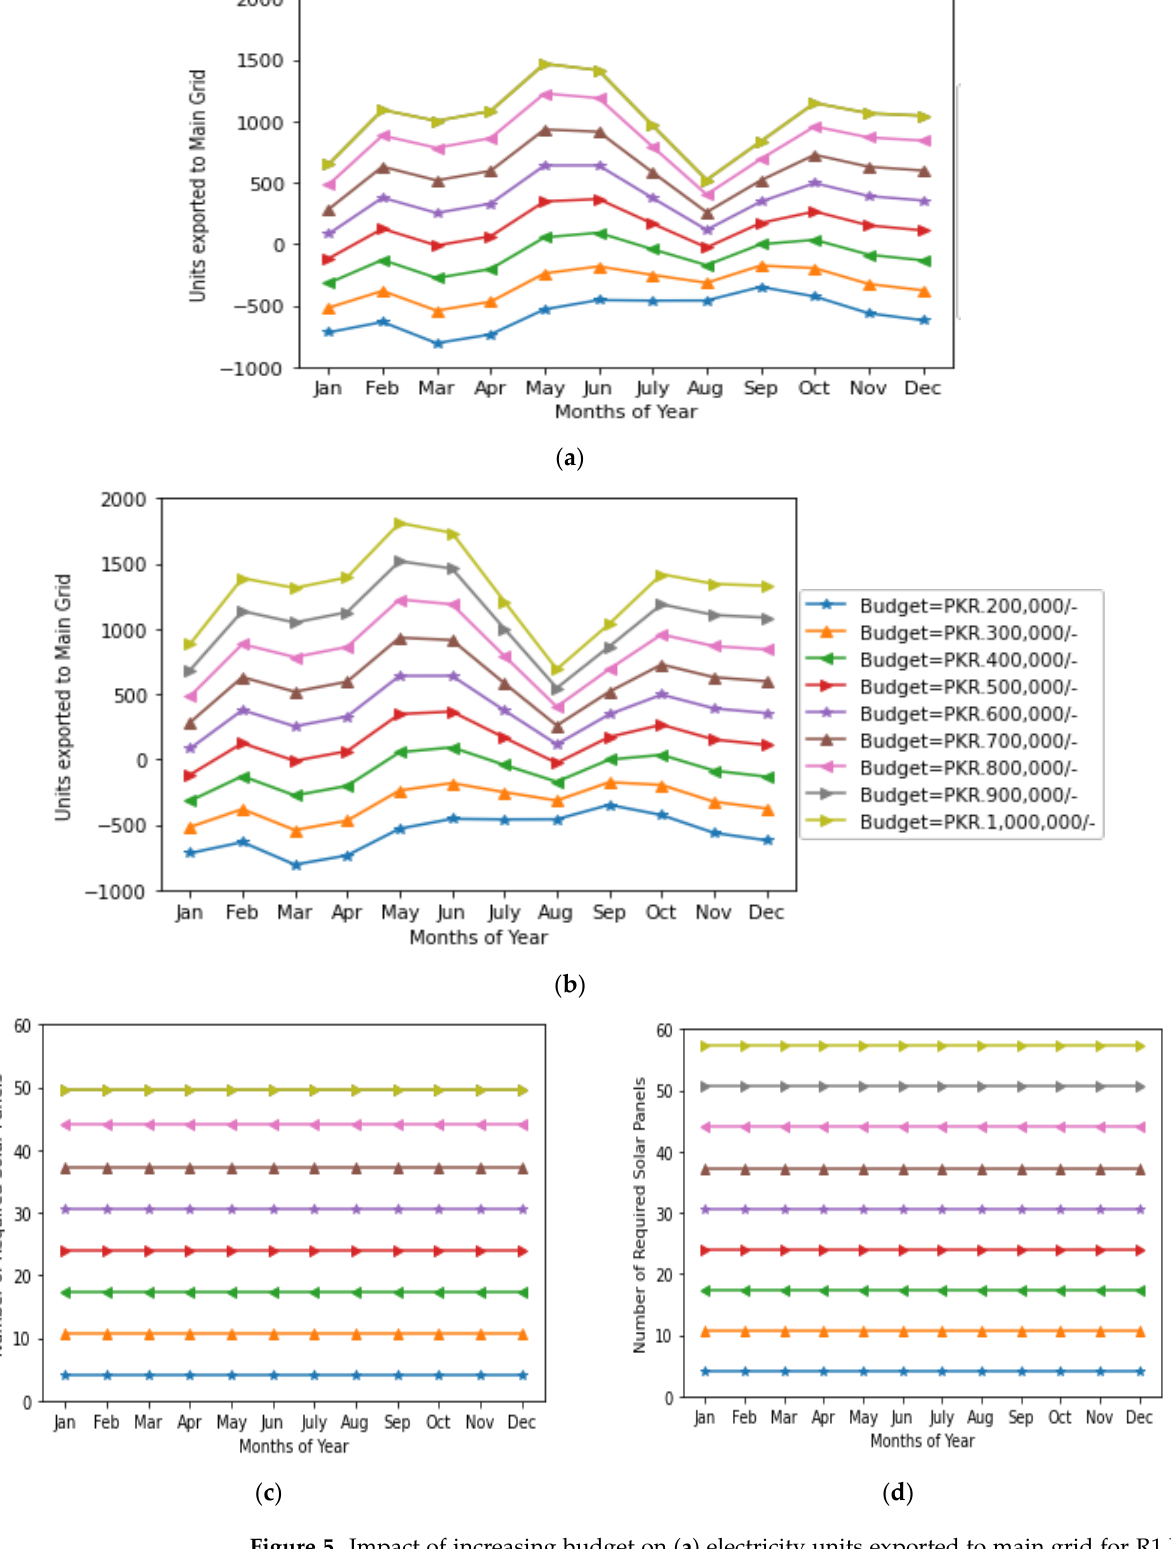
Figure 5. Impact of increasing budget on ( a ) electricity units exported to main grid for R1 house; ( b ) electricity units exported to main grid for R2 house; ( c ) optimized no. of solar panels required for R1 house; ( d ) optimized no. of solar panels required for R2 house.